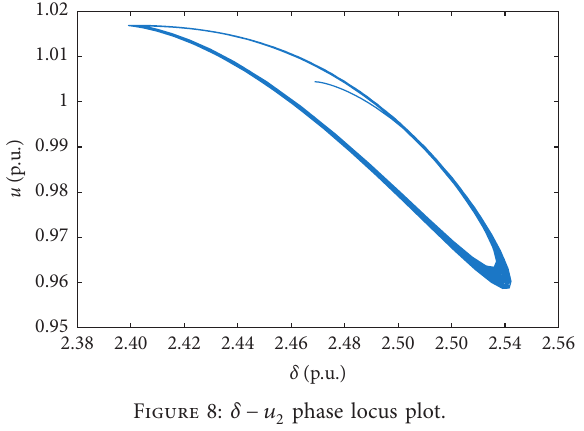
Figure 11: u − V simulation diagram.